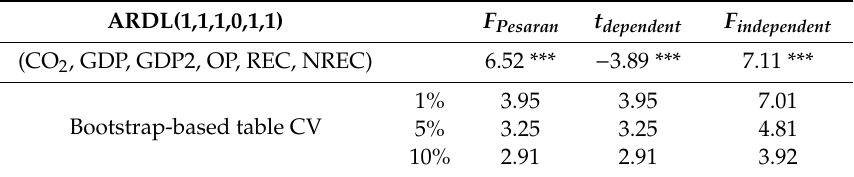
Table 3. The results of the bootstrap Autoregressive Distributed Lag model approach.